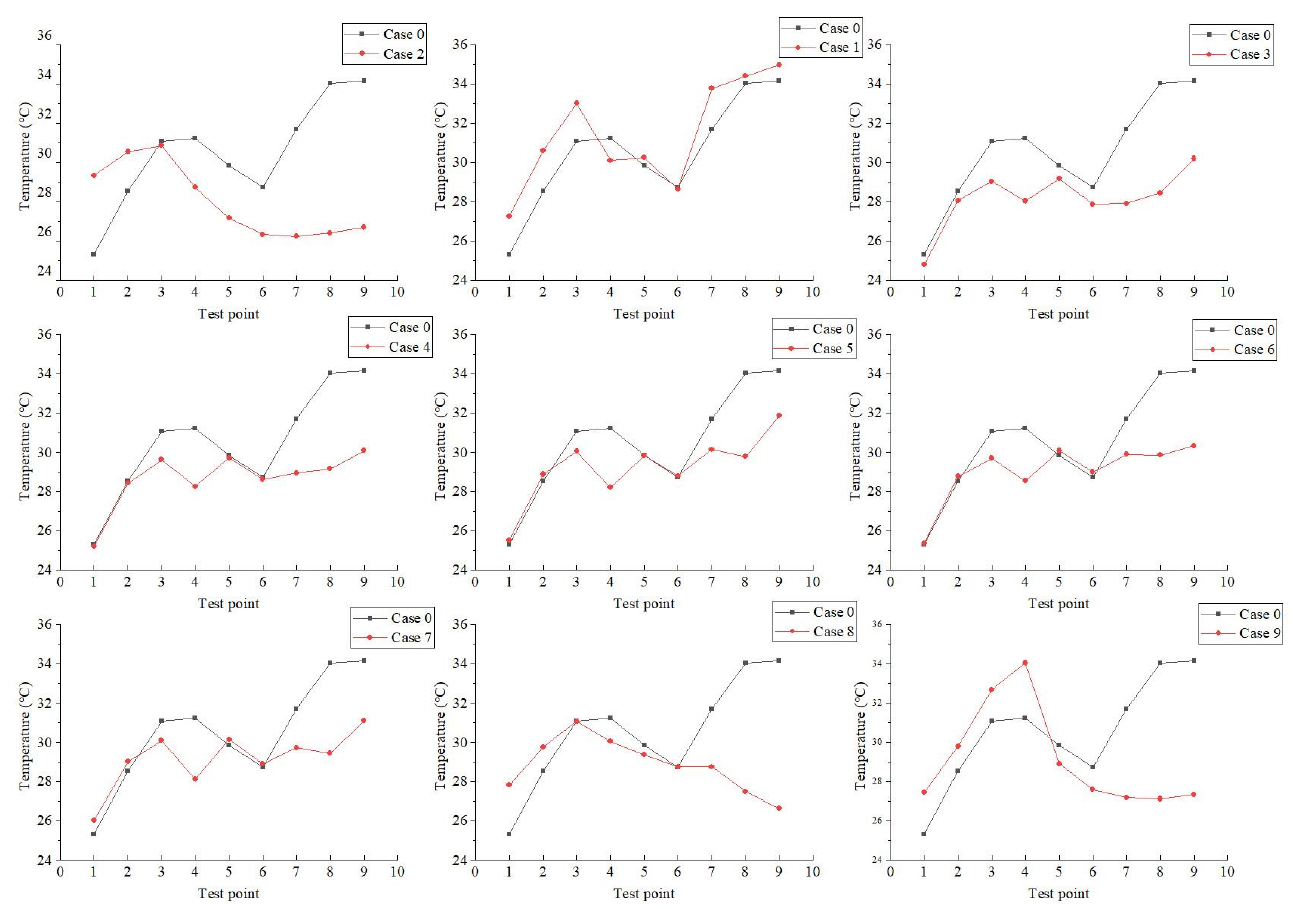
Figure 11. The temperature comparison of the nine temperature measurement points in the rack B4 without the heat pile (case 1) and by using HP with different distance from server (cases 2–8).